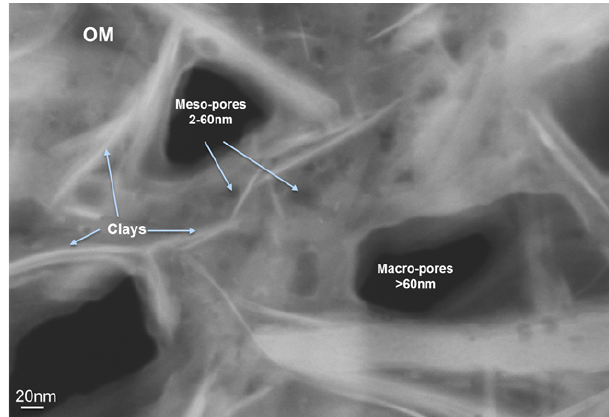
Figure 3. SEM-STEM imaging performed on a mud area enriched in organic matter (OM) and clays. Visualization of macro- and mesoporosity of few nanometers of equivalent diameters, which are either connected or distant of few